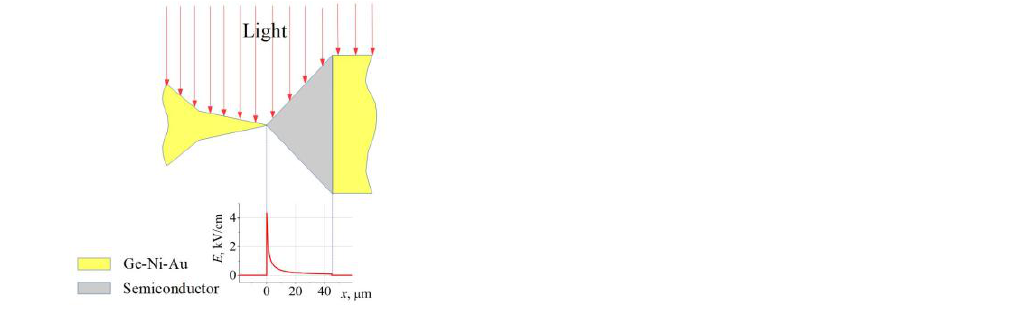
Figure 11. Schematic view of the bow-tie diode illuminated with light ( top ) and distribution of elec- tric field in the active region of the diode with 1 V of applied voltage.